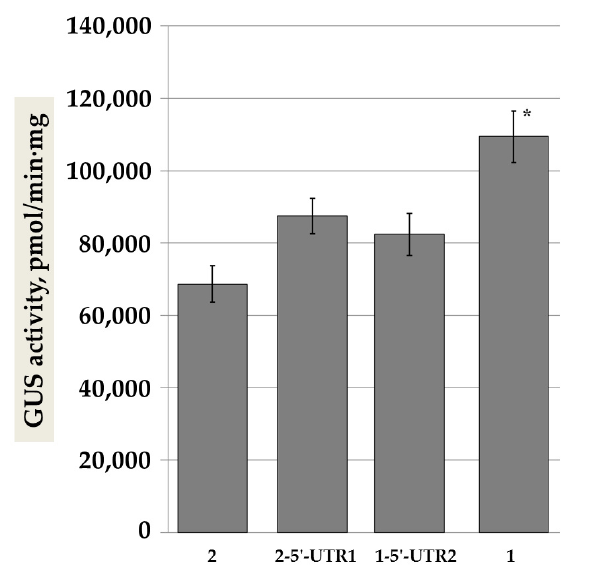
Figure 5. Activity of the GUS reporter in N. benthamiana leaves transiently expressing the pro-SmAMP1 (102) and pro-SmAMP2 (104) promoters and the 1-5 (cid:48) -UTR1 and 2-5 (cid:48) -UTR2 chimeric variants. The intact pro-SmAMP1 (102) and pro-SmAMP2 (104) promoters are indicated by the numbers 1 and 2, respectively. Vertical lines show standard errors, n = 80 for each construct. The plants were cultivated in a 16-h light / 8-h dark photoperiod. The asterisk marks significant di ff erence relative to pro-SmAMP2 by Student’s t -test (* p = 0.05).